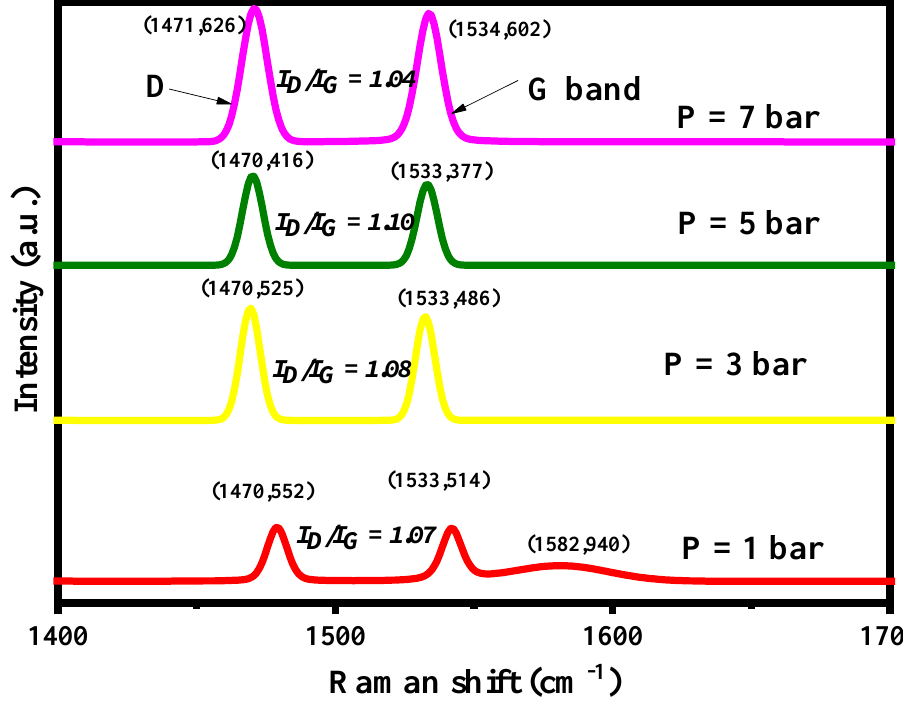
Figure 13. Room temperature Raman spectra of used catalysts upon 532 nm excitation.